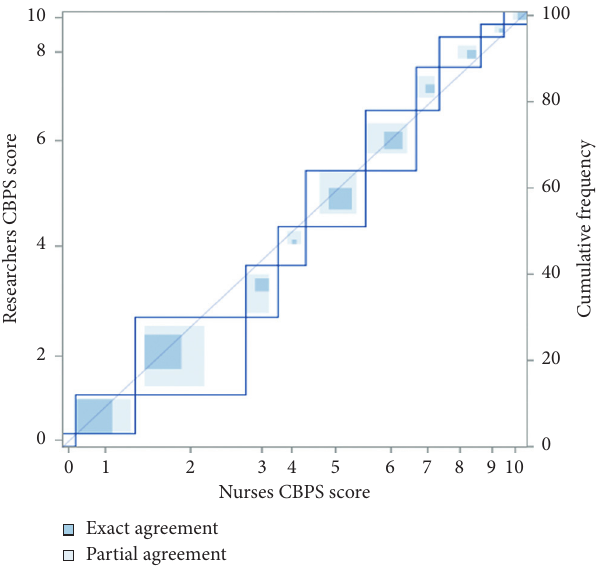
Figure 1: Interrater reliability for CBPS scores between nurses and researchers preprocedure.